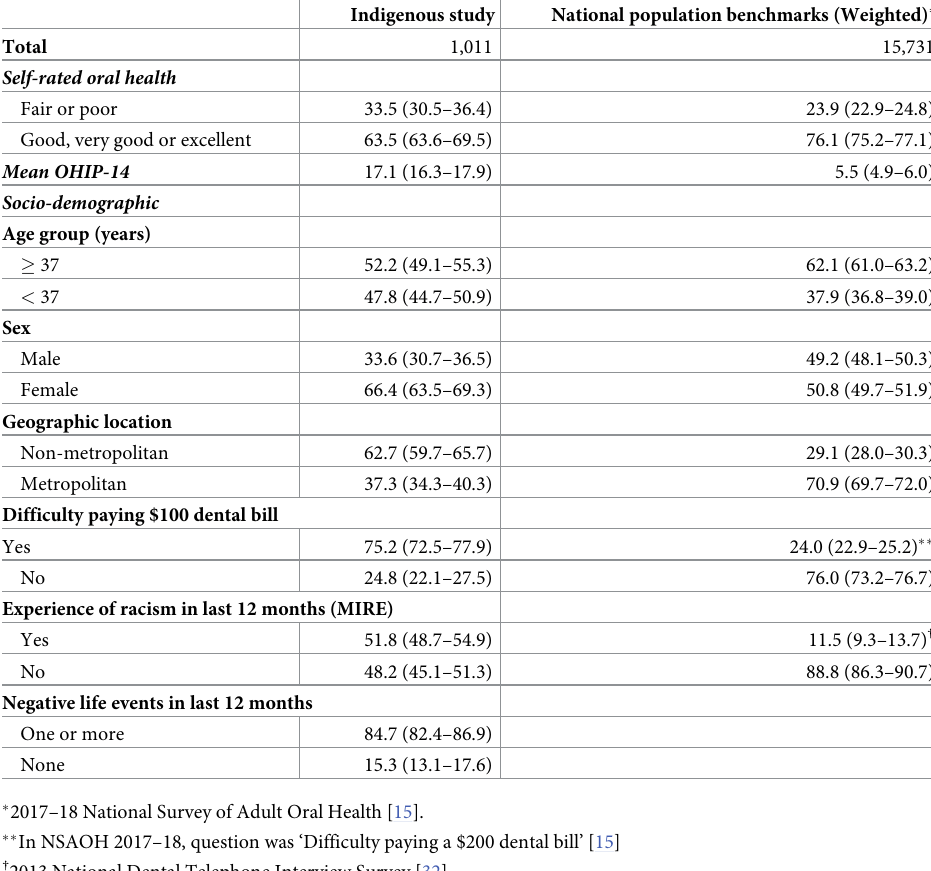
Table 1. Self-reported oral health, socio-demographic characteristics, health-related characteristics, experience of racism and negative events in last 12 months for Indigenous Australians, compared with national population benchmarks (percent, 95%